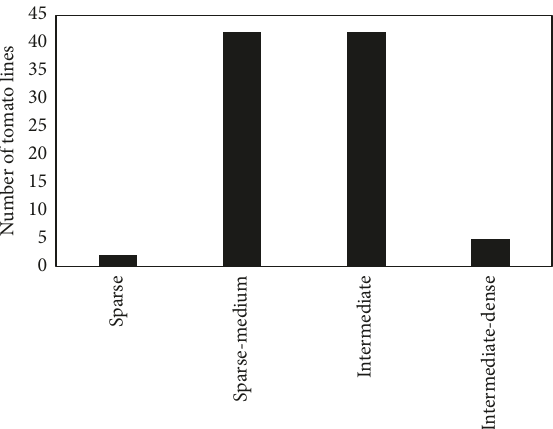
Figure 2: Foliage density distribution of tomato